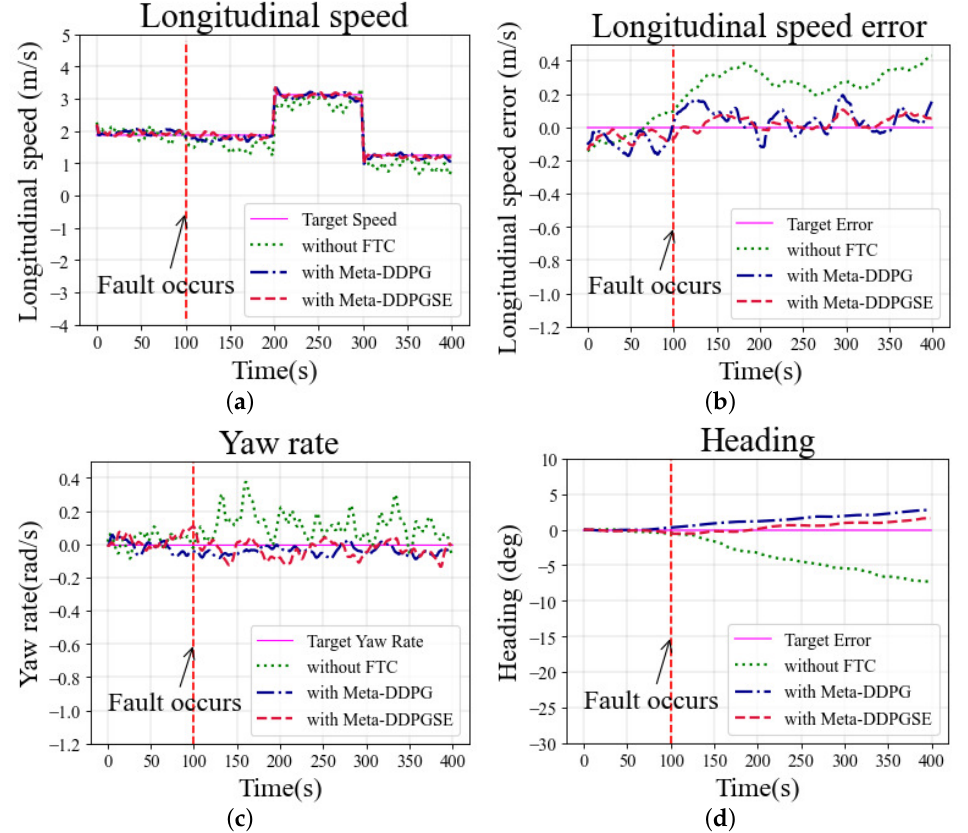
Figure 8. Simulation results in the straight scenario with fault F ∗ tudinal speed error; ( c ) Yaw rate; ( d )